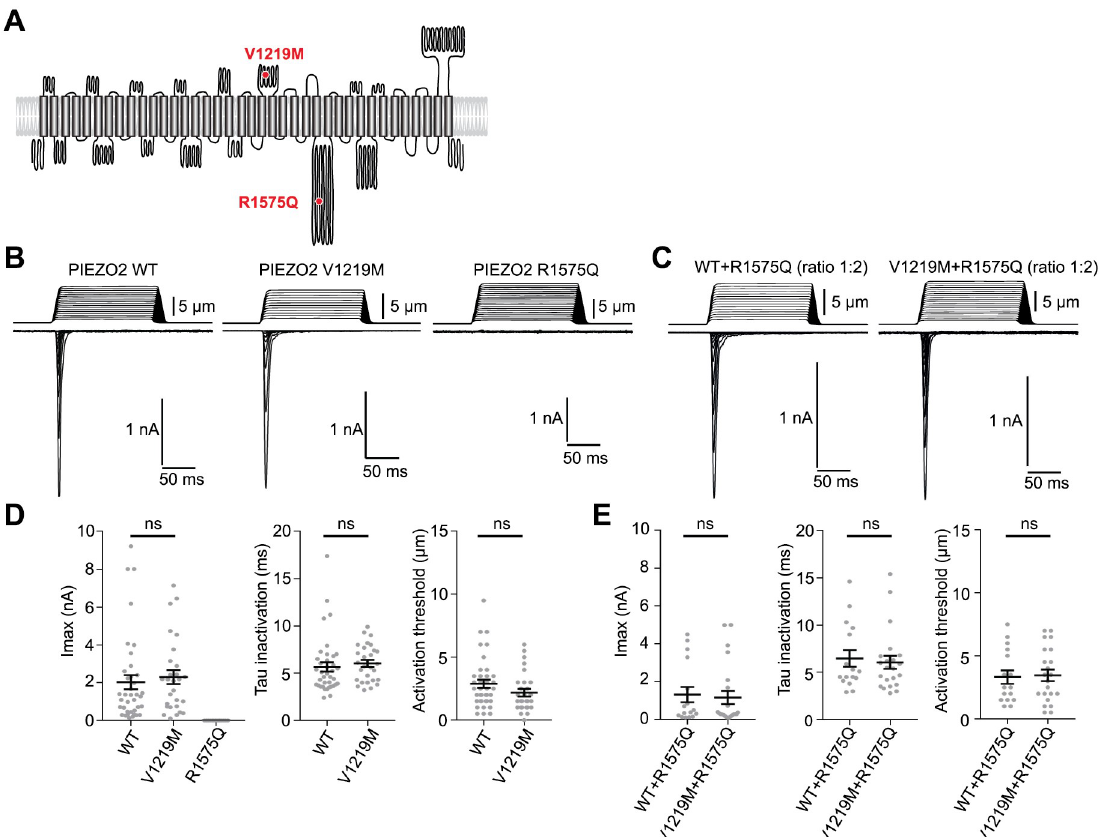
Fig 3. A —Schematic topology of PIEZO2 protein with position of the two identified mutation. B, C —Typical example of mechanically- activated currents recorded in HEK293T-P1KO cells transiently transfected with each specified constructs (600ng expression plasmid per condition) (B) or co-transfected with WT+R1575Q or V1219M+R1575Q at a ratio of 1:2 (300ng+600ng plasmid per condition) (C). Holding potential is -80mV. Top traces represent the displacement of the stimulation probe, bottom traces represent the recorded currents. Traces corresponding to mechanical stimulations incremented by 0.5 μ m are superimposed. D, E —Average maximal current amplitude (left panel), inactivation time-constant (middle panel) and threshold for mechanical current activation (right panel). Cells were recorded 24 to 48 hours post transfection transfection (n = 38, 28 and 14 for WT, V1219M and R1575Q, respectively; n = 16 and 22 for WT +R1575Q and V1219M+R1575Q, respectively; mean ± s.e.m.; Mann-Whitney test).